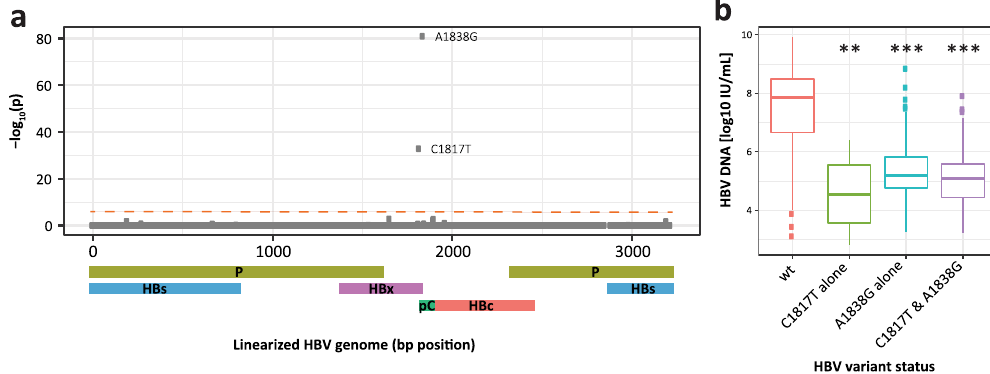
Figure 1. HBV variants associated with viral load. ( a ) Manhattan plot showing association (Likelihood Ratio Test p value, see methods) between HBV variants at a given genomic position and patient’s viral load (serum HBV DNA levels). Schematic below x axis represents HBV genome structure. P – polymerase, S – surface protein, C – core protein, pC – pre-core region, X – HBx protein. Bonferroni correction leads to a significance threshold of approximately 1.6 × 10 − 6 indicated by red dashed line. ( b ) Patients with high C1817T and A1838G variant frequency (based on 10% cutoff, see methods) had significantly lower HBV DNA levels. Wilcoxon rank sum test: * p < 0.05; ** p < 0.01; *** p <